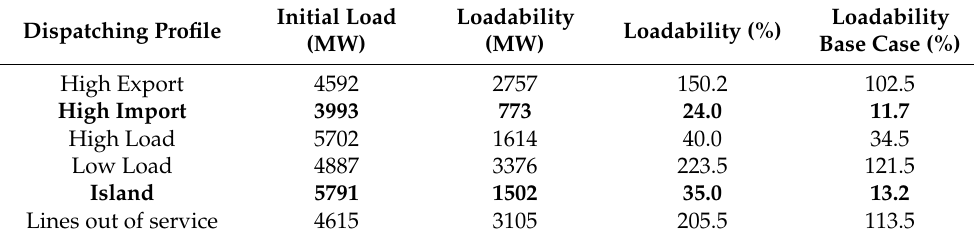
Table 21. Loadability margins for the selected DPs with the full RES reactive contribution.